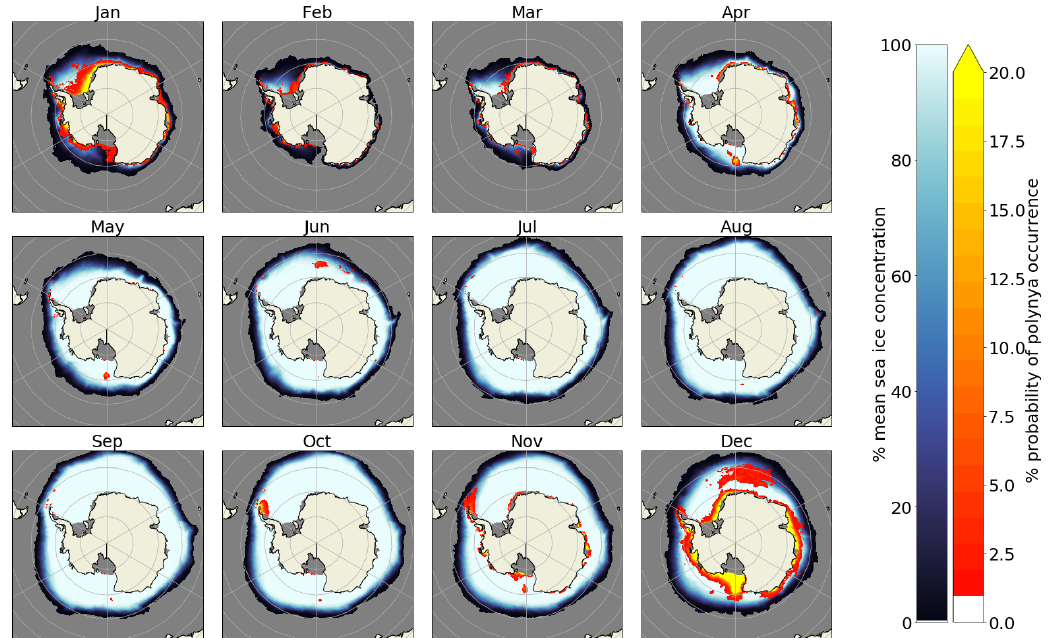
Figure A5. The seasonal cycle of sea ice concentration (blue colours) and polynya probability (red–yellow) for the GFDL-CM4 model.